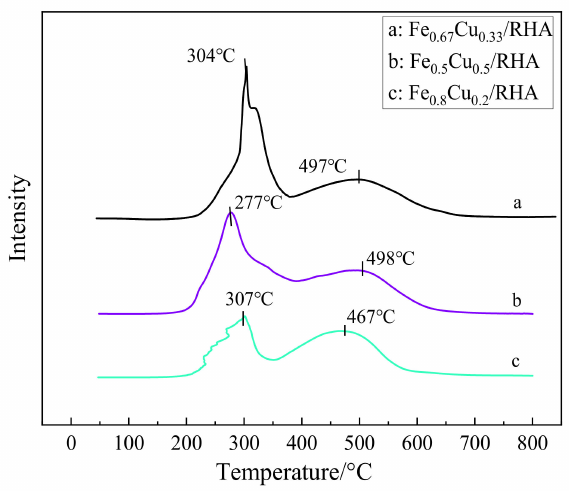
Figure 5. H2-TPR profiles of